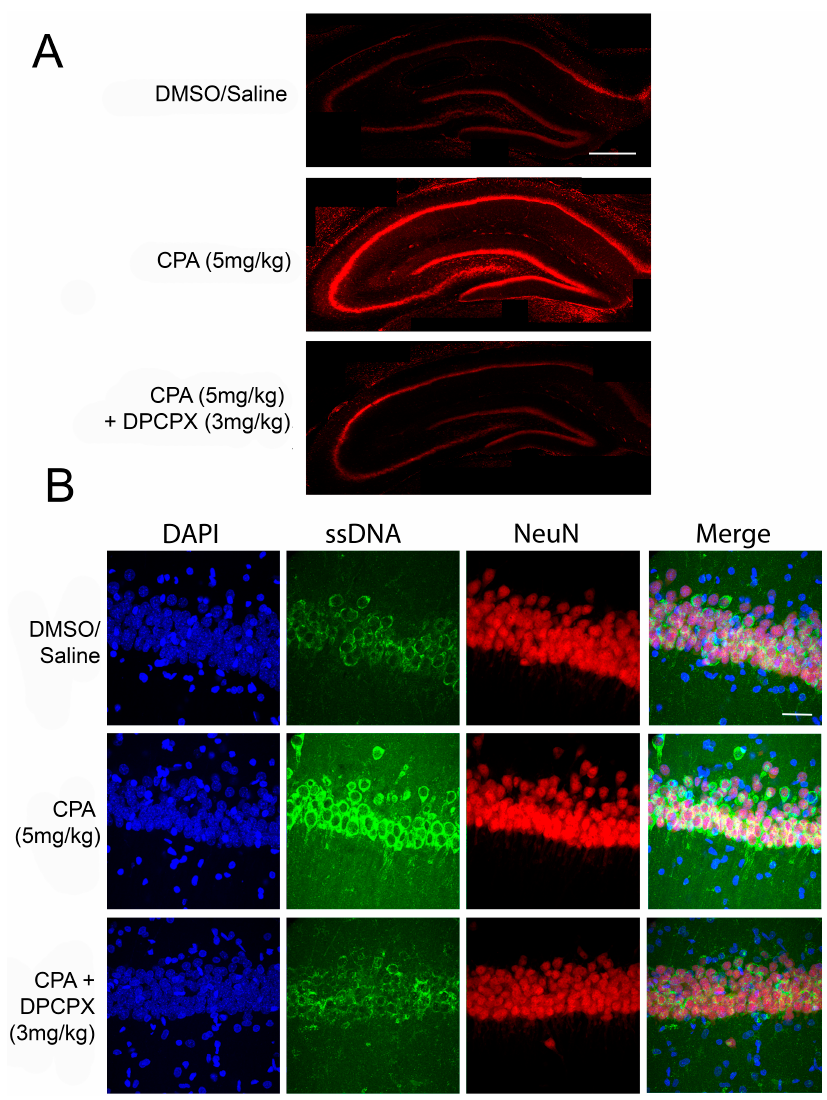
Figure 1. Adenosine A1R activation induces neuronal death in vivo. ( A ) Representative confocal microscopy images showing hippocampal slices stained with propidium iodide, a fluorescent marker for cell death. Male Sprague-Dawley rats were given intraperitoneal (i.p.) injections of CPA (5 mg/kg) or CPA (5 mg/kg) + DPCPX (3 mg/kg) and sacrificed at 48 h following initial injection. Acute coronal brain slices were taken and stained with propidium iodide. In animals treated with CPA alone, there was significantly increased propidium iodide fluorescence, indicating increased cell death in the hippocampus. DPCPX treatment prevented CPA-induced neuronal death. Scale bar 0.5 mm; ( B ) Confocal microscopy images of area CA1 of rat hippocampal slices with the same in vivo treatments above. DAPI, a nuclear stain is shown in blue (far left panels), single-stranded DNA (ssDNA) shown in green (second from left panels), NeuN shown in red (second from right panels), and a merge of all three channels shown in the far right panels. The marker ssDNA was used to label apoptotic cells, while NeuN (a neuronal marker) was used to label the CA1 cell layer. CPA treatment caused increased ssDNA staining in CA1 compared to control and DPCPX + CPA treated brains, indicating that CPA treatment was pro-apoptotic. Scale bar 30 µ